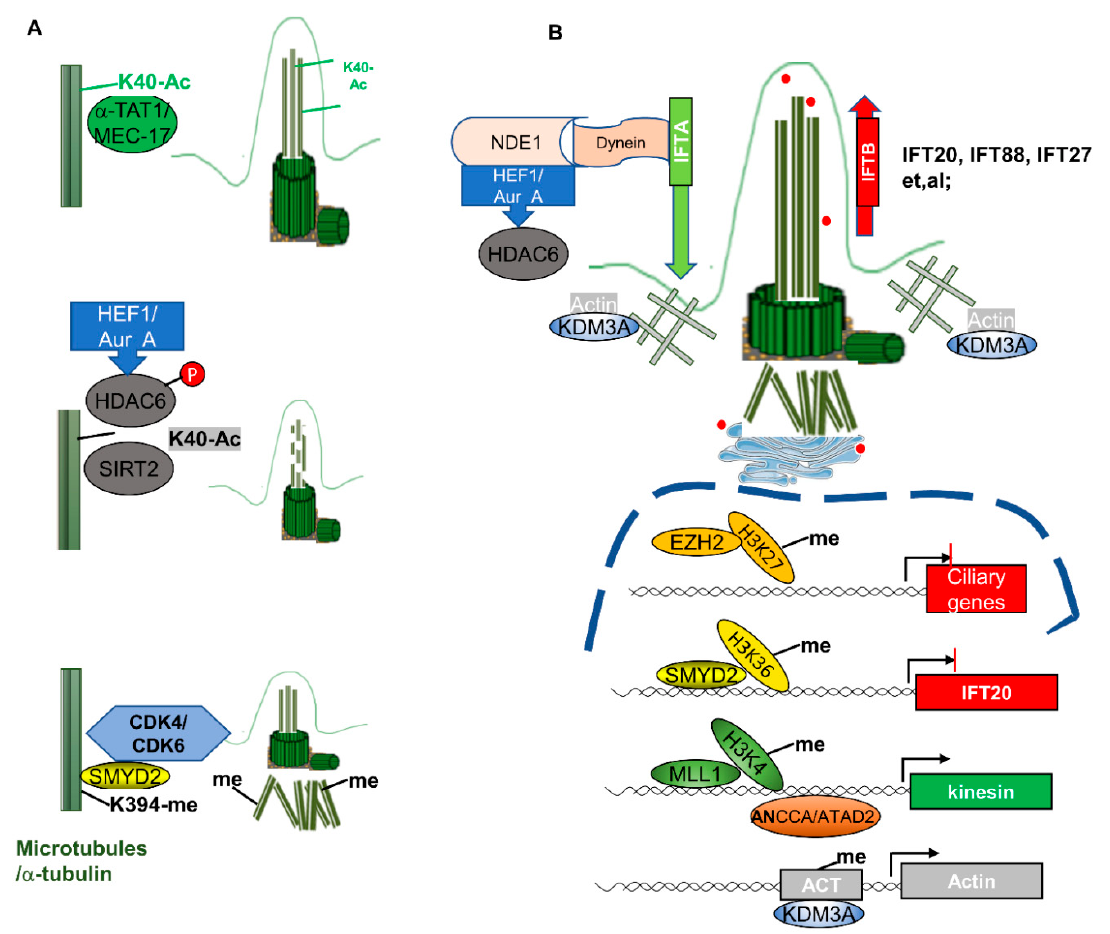
Figure 3. The mechanisms of epigenetic regulators in the regulation of cilia biogenesis. ( A ) Epigenetic regulators regulate cilia biogenesis through modifications of α -tubulin. Top panel: α -TAT1 and MEC-17 mediated the acetylation of α -tubulin at K40, which facilitates the incorporation of α -tubulin into axoneme, promoting cilia assembly. Middle panel: HDAC6- and SIRT2-mediated deacetylation of α -tubulin destabilizes the cilia, resulting in cilia disassembly and short cilia. Bottom panel: SMYD2-mediated methylation of α -tubulin at K394 is accumulated at the basal body, but not in the axoneme, which also facilitates cilia disassembly, resulting in shorter cilia. ( B ) Epigenetic regulators regulate cilia biogenesis by regulating the transcription of ciliary genes. Epigenetic regulators—including EZH2, SMYD2, MLL1, and KDM3A—can regulate the transcription of ciliary genes through modification of histone markers, or by directly binding to the promoters of those genes. For example, KDM3A regulates ciliogenesis by regulating the expression of actin, and by binding to the actin cytoskeleton, creating a responsive “actin gate” that controls the access of IFT proteins to the